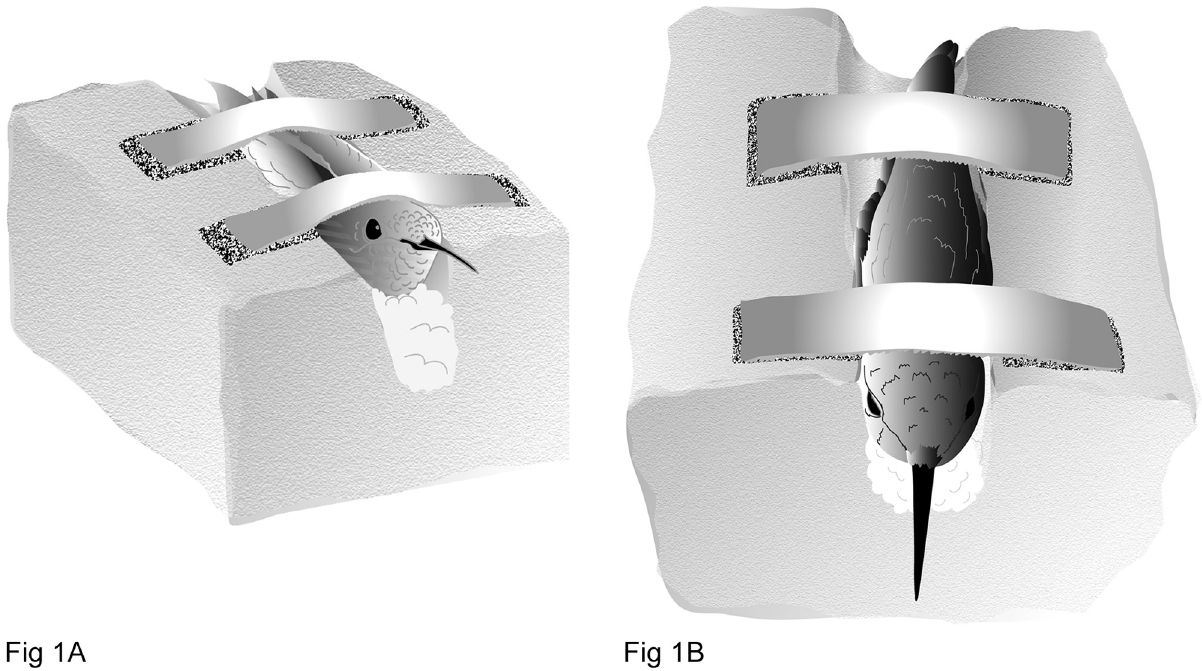
Fig 1. Side (A) and top (B) view of polyethylene foam (1.7 pound per cubic foot) block used to restrain and secure hummingbirds for subcutaneous insertion of the passive integrated transponder in the dorsal lumbar region of the bird. Note that the bird holding reservoir is beveled so that the top portion is wider than the bottom section. The polyethylne foam is firm enough to secure the bird, but flexible enough not to restrict respiratory movement. Two re-closable fastener strips are used to hold the bird in place and a bird is placed in the block so that the wings are